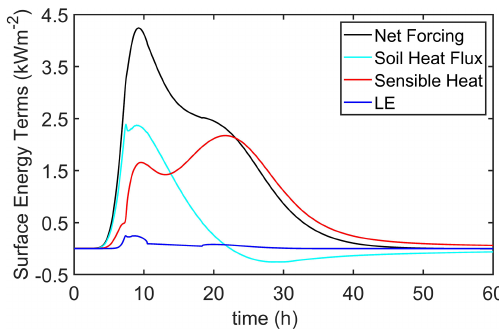
Figure 6. Replotted from Fig. 5 to facilitate comparison with the surface energy terms as simulated with the simplified surface energy balance, Eq. (18), and shown in Fig.